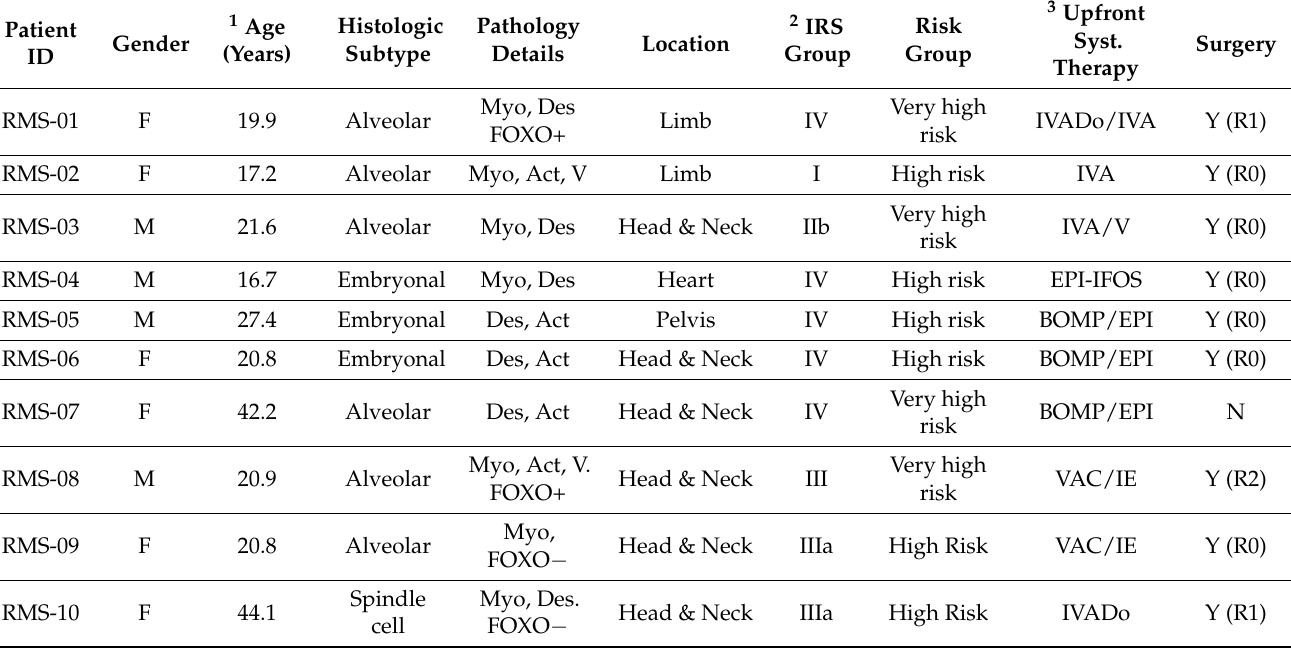
Table 1. Demographic and clinical characteristics from the